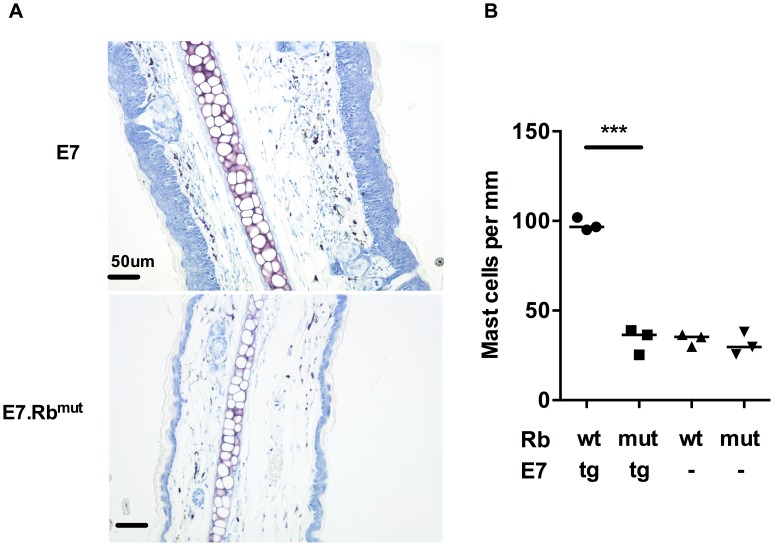
MC infiltration in ear skin is dependent on E7 hyperplasia.E7.Rbmut ear skin is not hyperplasic and contains normal MC numbers. (A) Representative images of E7.Rbwt and E7.Rbmut ear skin by toluidine blue stain (original magnification ×400, scale  = 50 µm). (B) MC number per mm cartilage length (n = 3 in each group). ***p<0.001 by unpaired t-test for indicated comparison. Rbwt are same as C57.